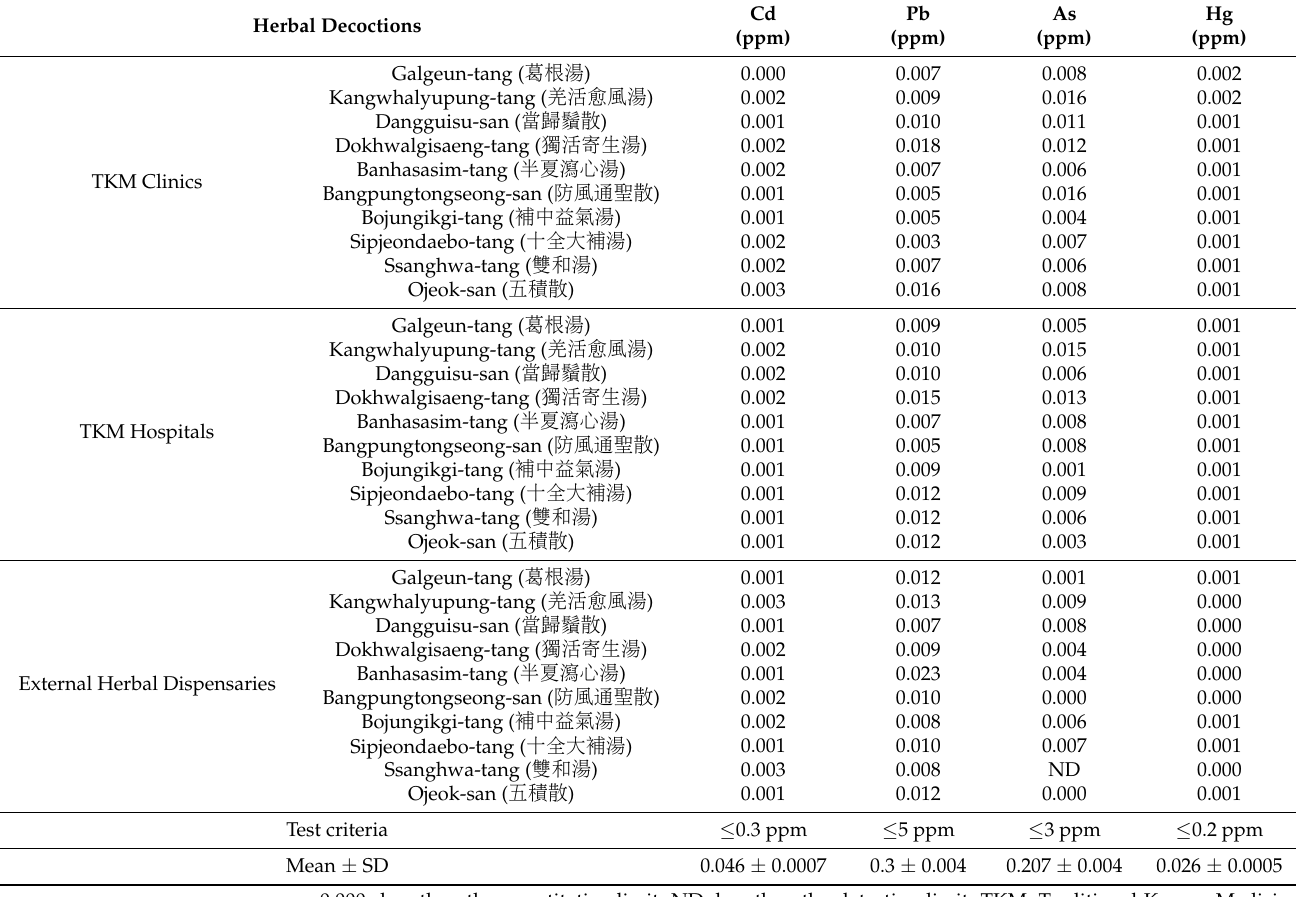
Table 5. Heavy metal detection result of herbal